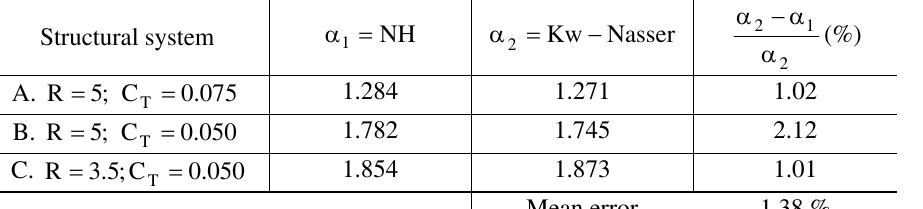
Table 3. Mean values of the amplification coefficient α , while considering (HN) and not considering site effect (Kw -